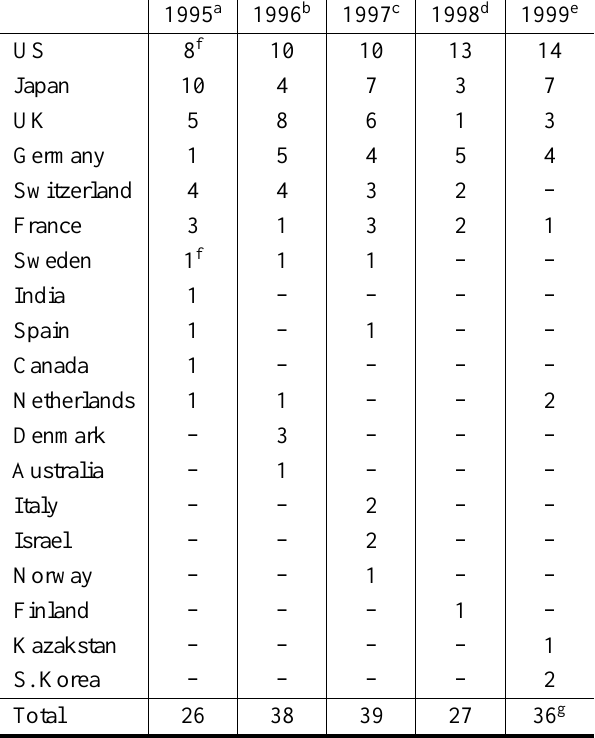
New Chemical Entities (NCEs) by country of origin,